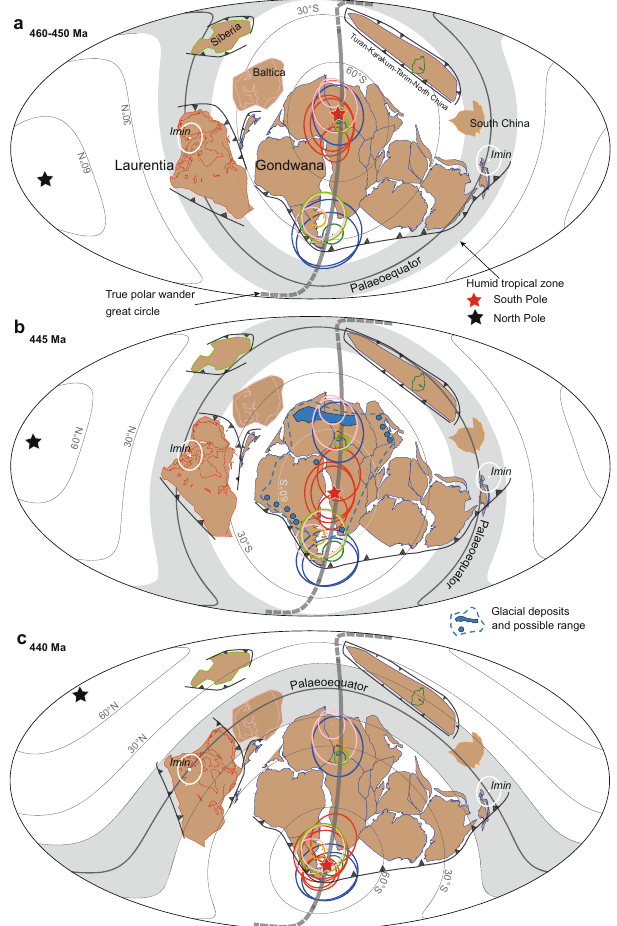
Fig. 5 | Palaeogeographic reconstructions based on Ordovician – Silurian true polar wander. Reconstructions for: ( a ) 460 – 450Ma, ( b ) 445Ma, and ( c ) 440Ma. Palaeomagnetic poles are color-coded as in Fig. 3a. I min , minimum moment of inertia (equatorial true polar wander axis of rotation). Palaeomagnetic poles (and associated continents) of each age are rotated to coincide with the South Pole, although a 5 – 10° range of fl exibility is occasional adopted as is common praxis in ancient palaeomagnetic reconstructions. The latitudinal band between 15° north and south of the Equator is assigned as the humid tropical zone with intensive chemical weathering. Maps are shown in Mollweide projection. For better dis- playing their distribution, we fi xed the continents and rotate the Mollweide pro- jection to fi t the Palaeo-south pole. All plots were generated with GPlates 73